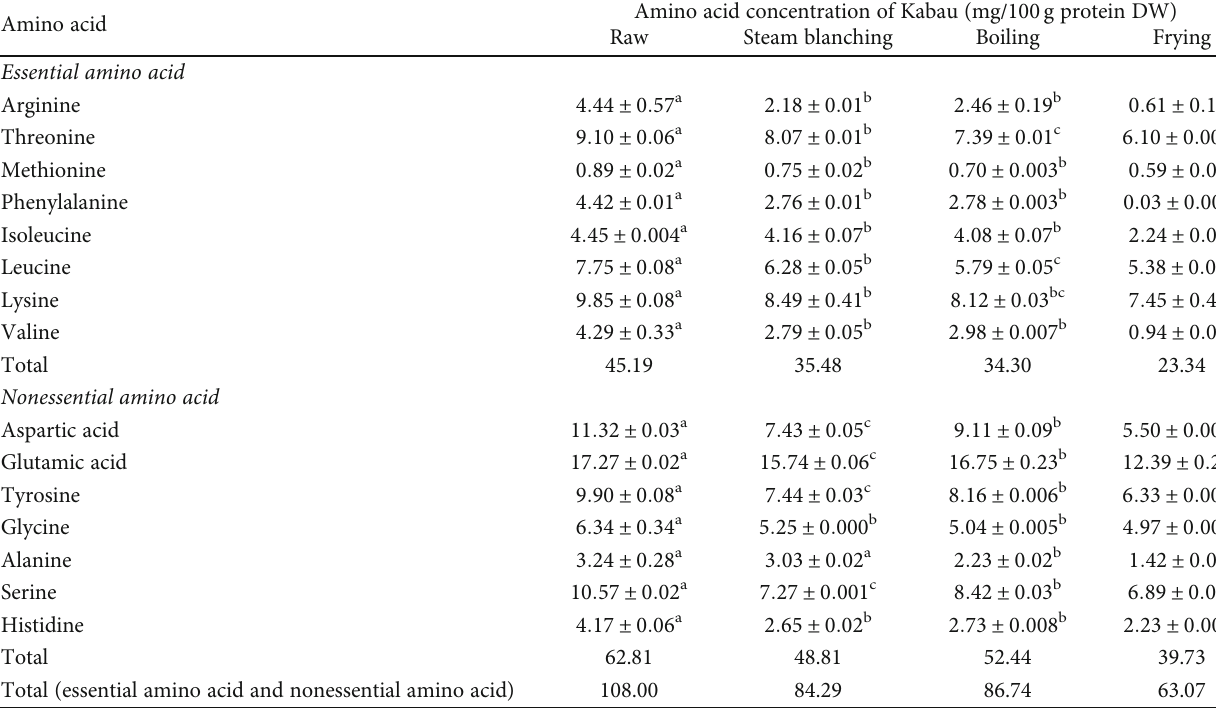
Table 3: Amino acid pro fi le of Kabau on di ff erent conventional processing techniques. Amino acid concentration of Kabau (mg/100g protein Amino acid